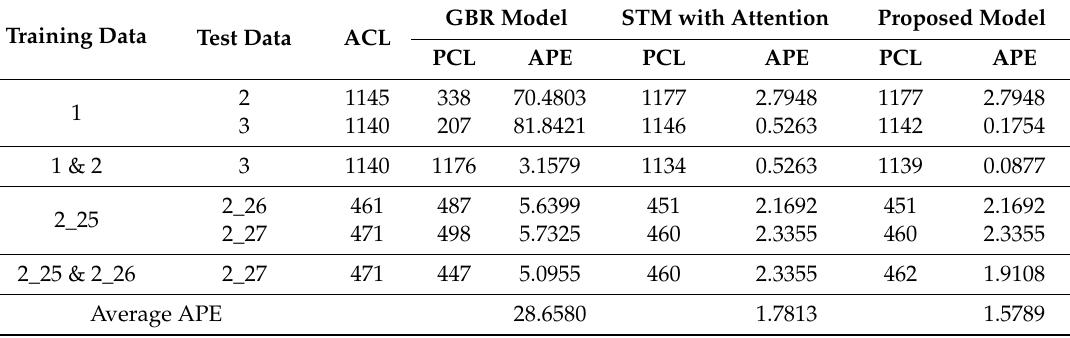
Table 7. The cycle life prediction results of di ff erent models using one cell or two cells as training data. Training